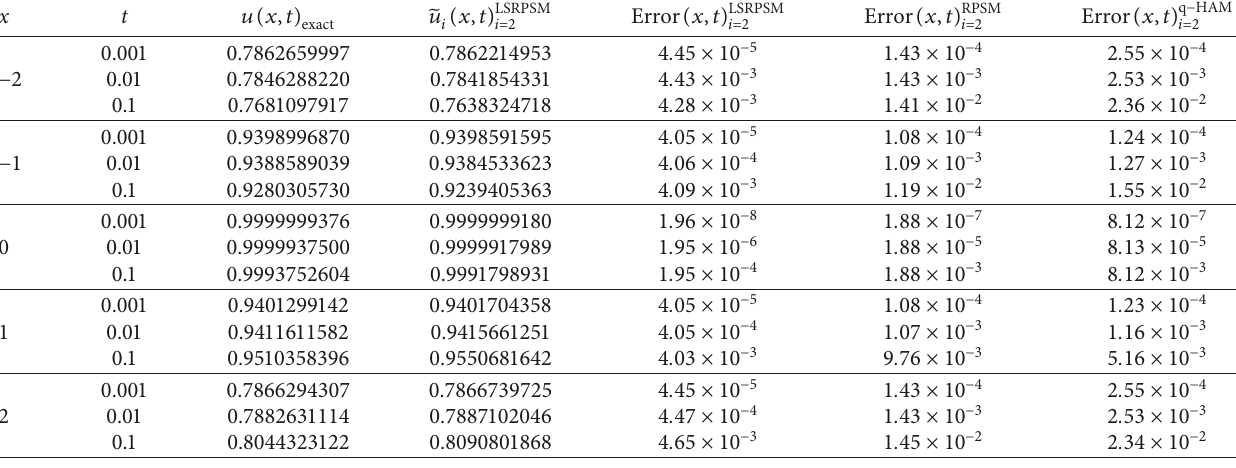
Table 3: Absolute errors by LSRPSM, RPSM, and q-HAM for α � 1.